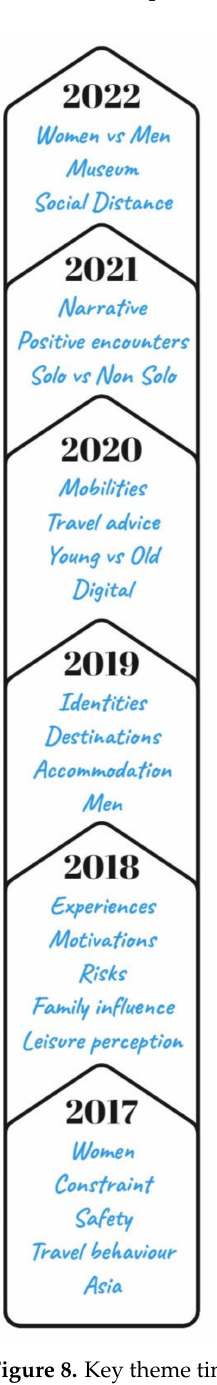
Figure 8. Key theme timeline,